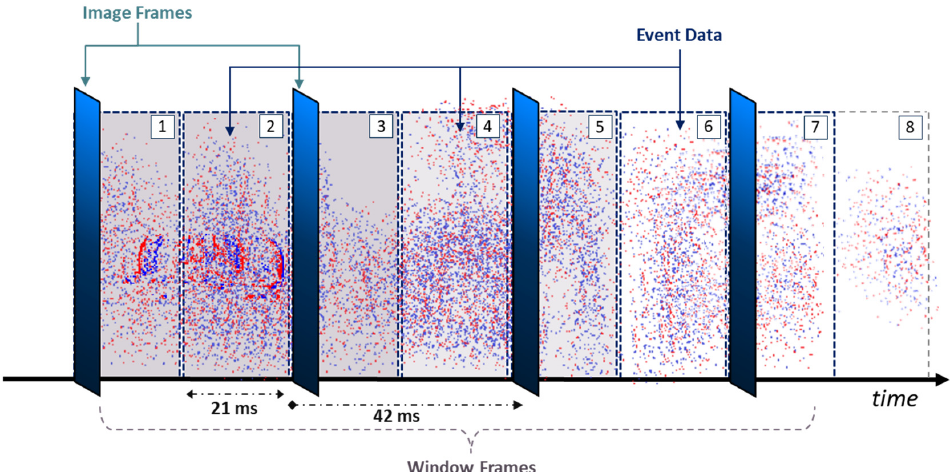
Figure 3. Visualization of a synchronized stream of image frames and event data over time. In this example, the image frames are captured at around every 42 ms (at a rate of 24 Hz), whereas the window frame size is set to a temporal resolution of 21 ms (tracking rate of 48 Hz). A window frame encapsulates any image frames and event data available in that specified time frame. A total of 8 window frames are demonstrated in this figure as indicated by their number.